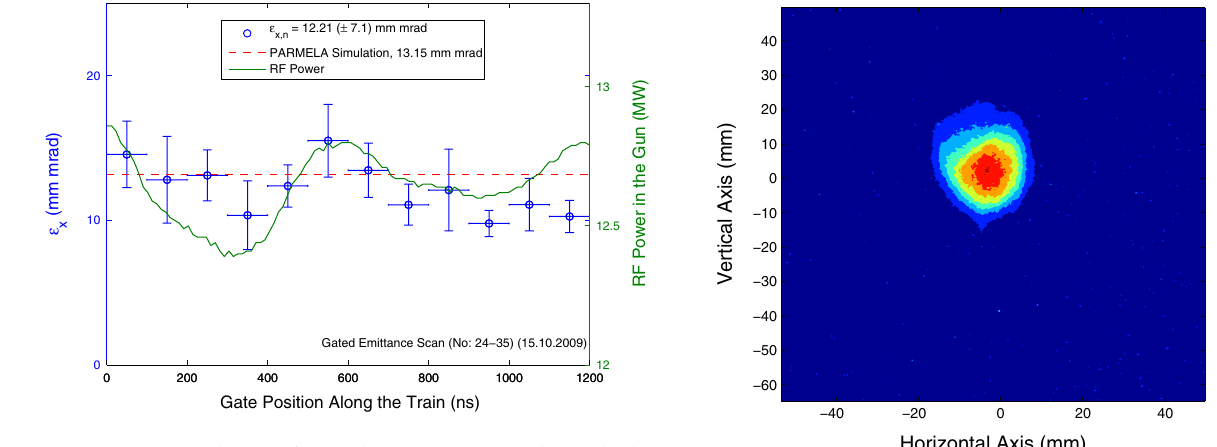
FIG. 13. The emittance fluctuations along the pulse train in comparison with the rf pulse shape. The measurement has been performed on a beam with the charge of 1 nC per bunch and the energy of 5